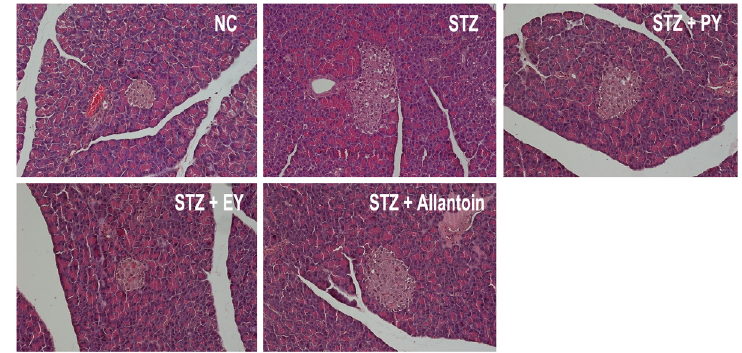
Figure 6. Microphotographs of pancreatic tissues (H ‐ E staining, 200×). NC, normal control; STZ, diabetic control; STZ + PY, crude yam powder ‐ treated diabetic; STZ + EY, water extract of yam ‐ treated diabetic; STZ + Allantoin, allatoin ‐ treated diabetic rats.